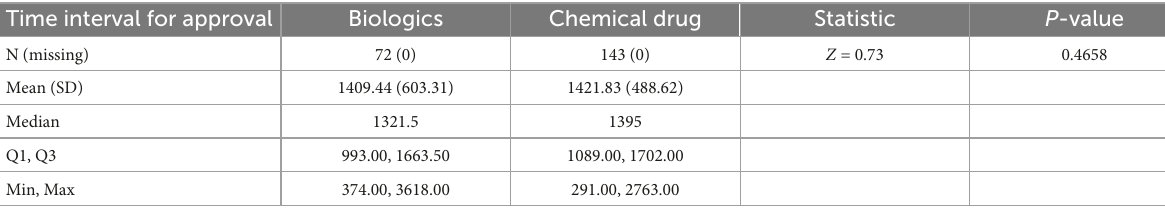
TABLE 12 Time interval for approval in MRCTs with different numbers of regions. Time interval for